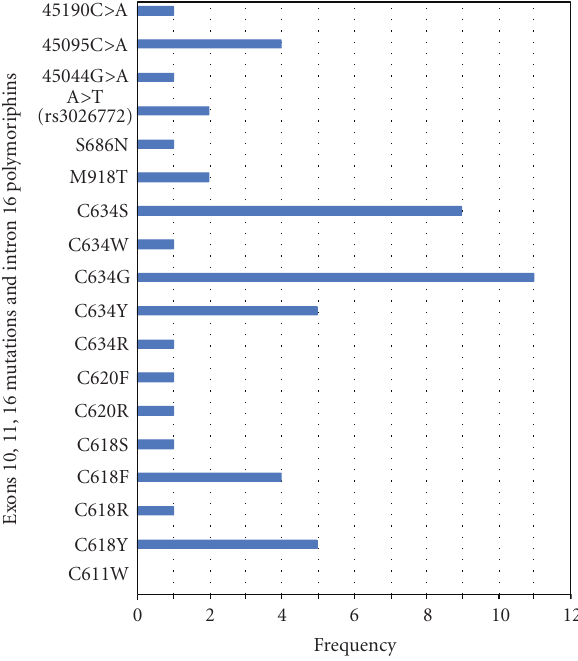
Figure 1: The allele frequency of the RET proto-oncogene muta- tions in Iranian patients with